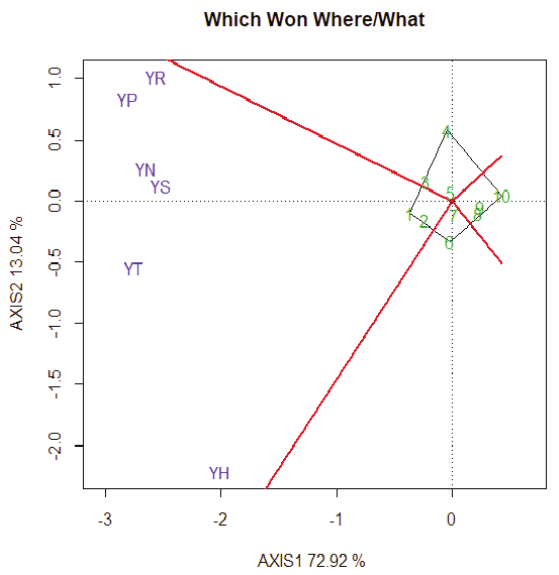
Fig. 4 ­ The accession × yield­trait biplot of ‘which won where’ of selected seven best and 3 worst Amaranthus